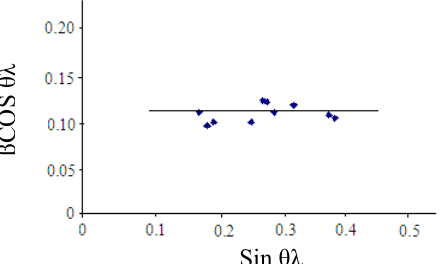
Figure 5 . Particle size